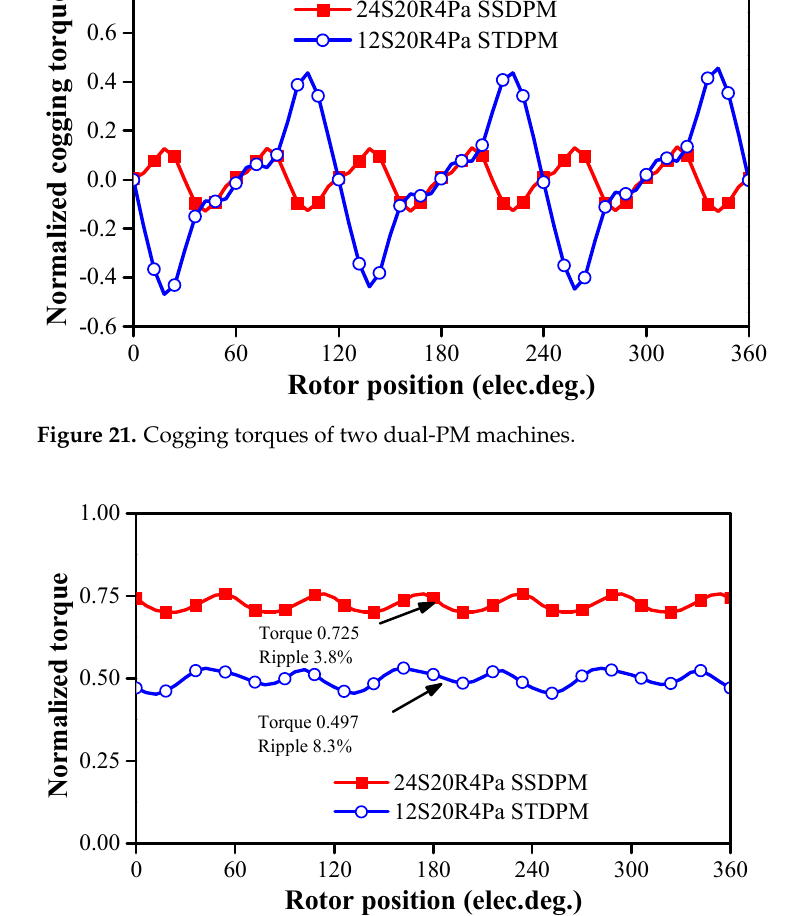
Figure 22. Torque waveforms of two dual-PM machines when I = I max and turn number per phase is adjusted to satisfy inverter requirements.